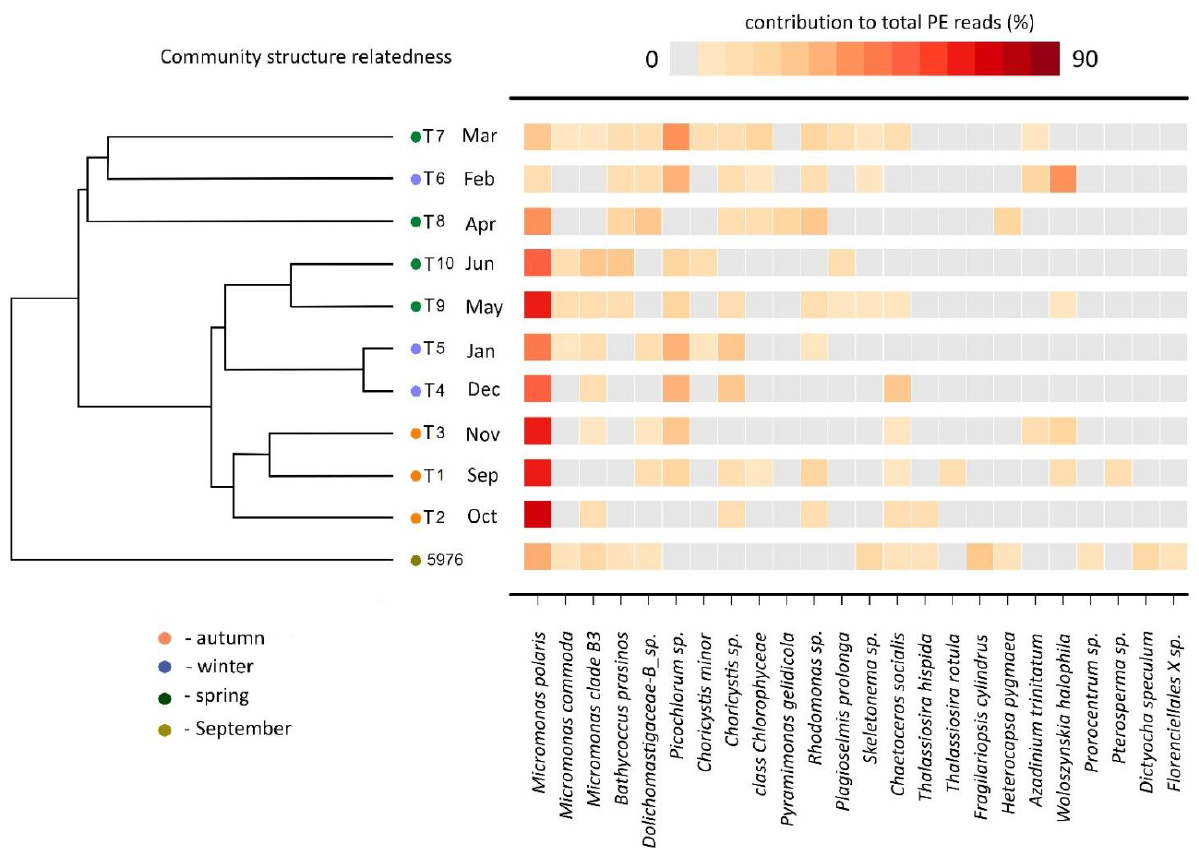
Figure 8. Heatmap showing the V4 reads representation of the 24 most abundant phototrophic eukaryotes. Community structure related cluster dendrogram was calculated using Bray–Curtis similarity based on the square root transformed relative reads abundance for each sample.